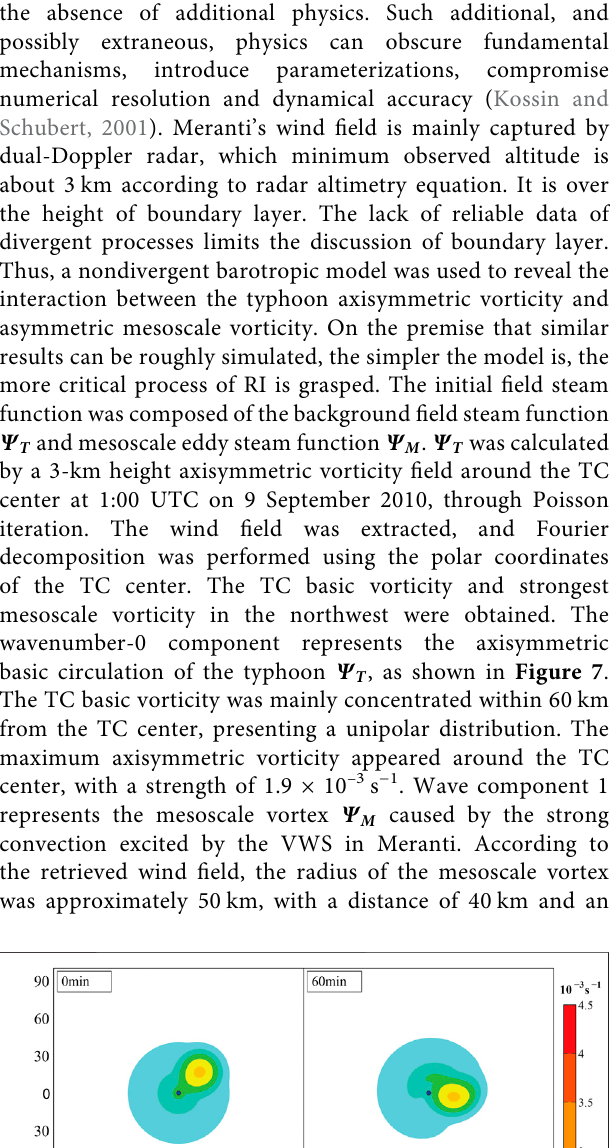
Frontiers in Earth Science |